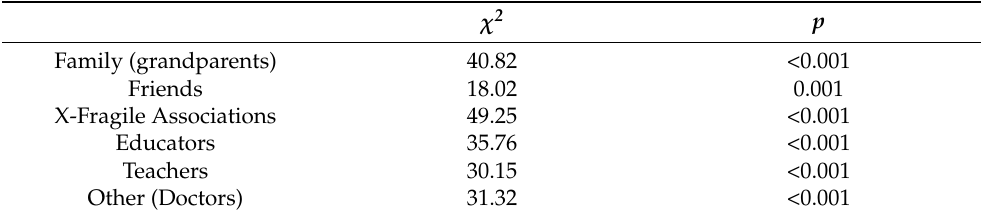
Table 2. Non-parametric statistics on the caregivers’ perception about the external support received in their children’s